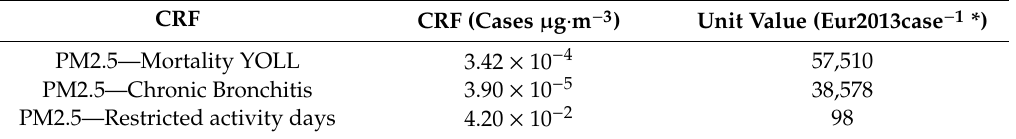
Table 2. Slopes and unit values of considered CRFs for PM2.5. Based on